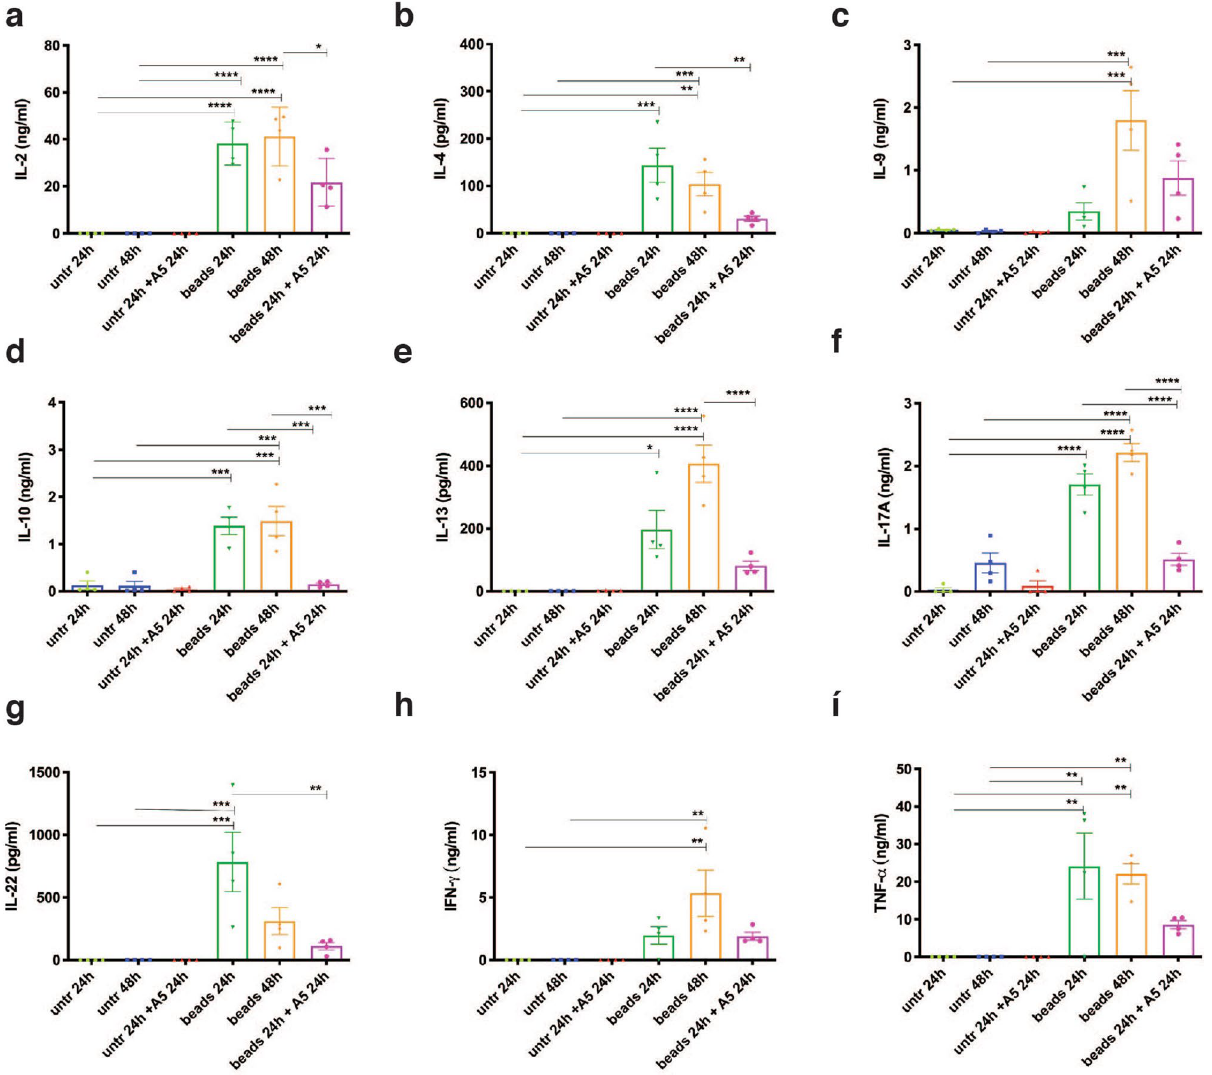
Figure 5. SDH inhibition affect cytokine production after T cell activation. ( a – i ) Secreted cytokines by CD4 + T cells after activation and compound-treatment (A5, 20 μM) measured by MSD and ELISA (n = 4 independent experiments, with n = 2 technical replicates). All charts show mean and ± s.e.m. P values are calculated using one-way ANOVA with Tukey multiple comparisons. *P < 0.05, **P < 0.01, ***P < 0.001, ****P <